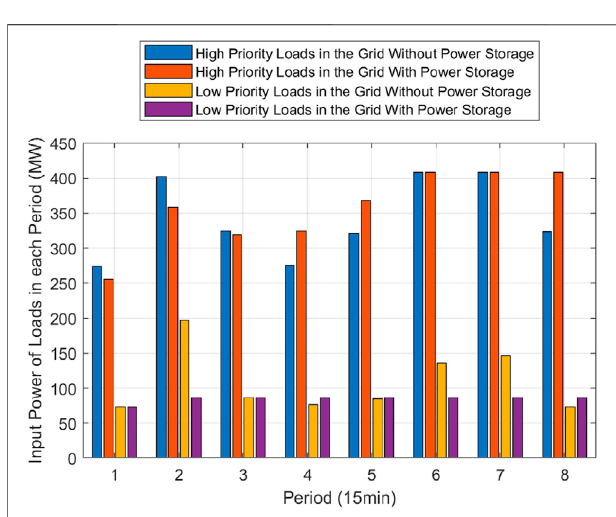
FIGURE 8 | Input power of loads in each period of the two systems.